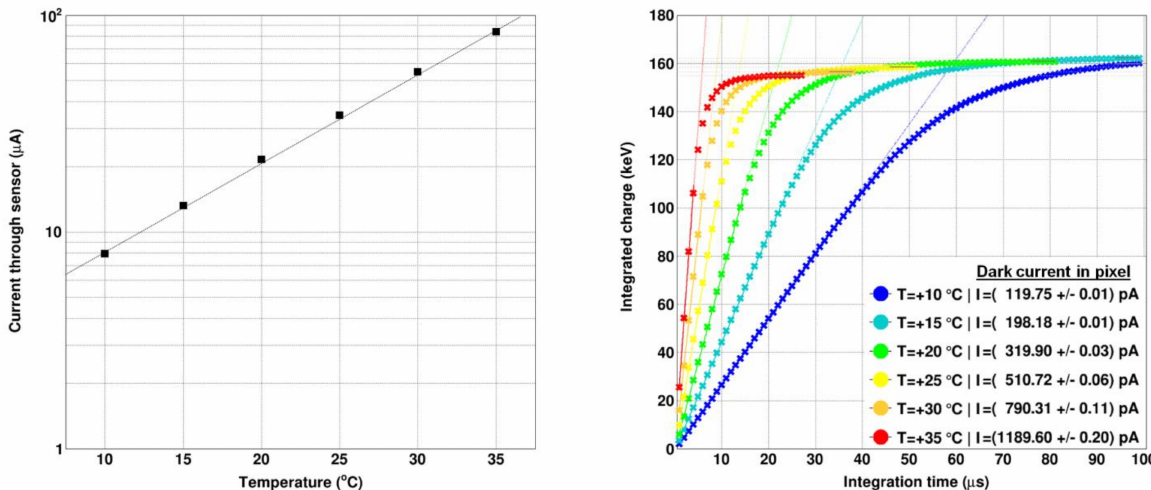
Figure 2. ( left ) Current through the 256 × 256 pixels of the sensor as function of the temperature, showing an exponential increase of the bulk current as function of temperature ( right ) Extracted current from an arbitrary pixel as function of the